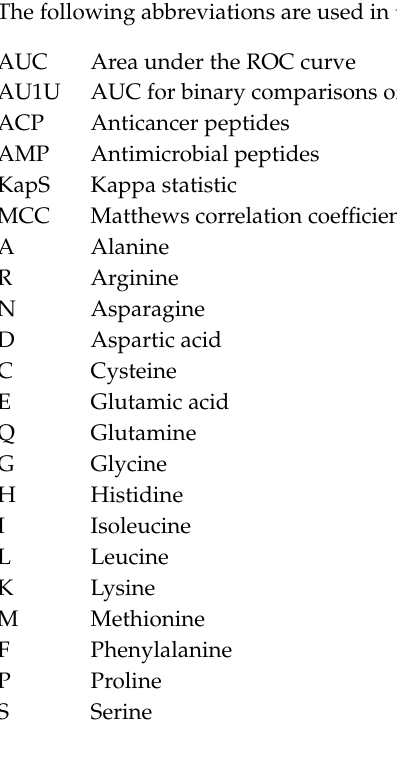
Table S1: Average amino acid percentages for ACPs and AMPs. The differences in amino acid composition between ACPs and AMPs were statistically evaluated using the Mann–Whitney U test with Benjamini–Hochberg correction. Table S2: Average amino acid percentages for ACPs and the negative data set. The differences in amino acid composition between ACPs and the negative data set were statistically evaluated using the Mann–Whitney U test with Benjamini–Hochberg correction. Table S3: Average amino acid percentages for AMPs and the negative data set. The differences in amino acid composition between AMPs and the negative data set were statistically evaluated using the Mann–Whitney U test with Benjamini–Hochberg